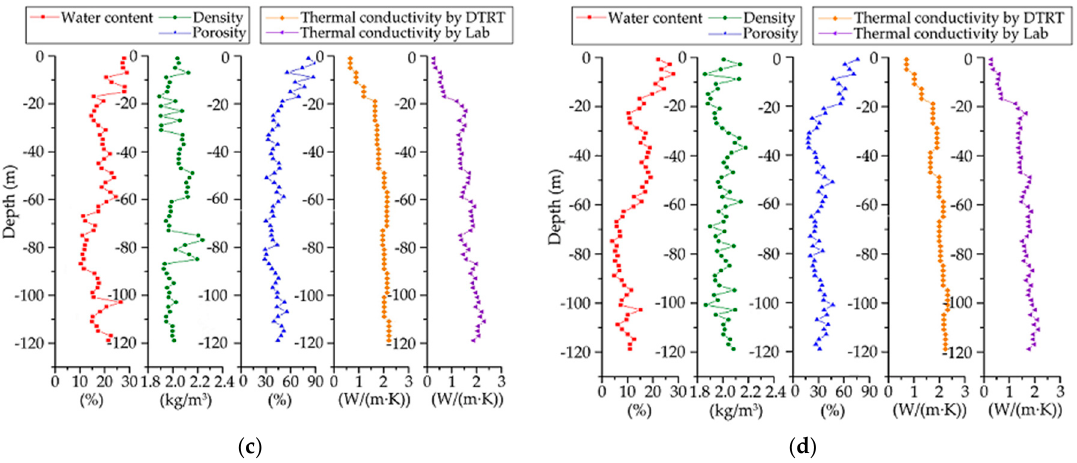
Figure 7. Testing results of the laboratory tests and the DTRT. Clockwise from top left: ( a ) ZK01, ( b ) ZK02, ( c ) ZK03, and ( d ) ZK04.